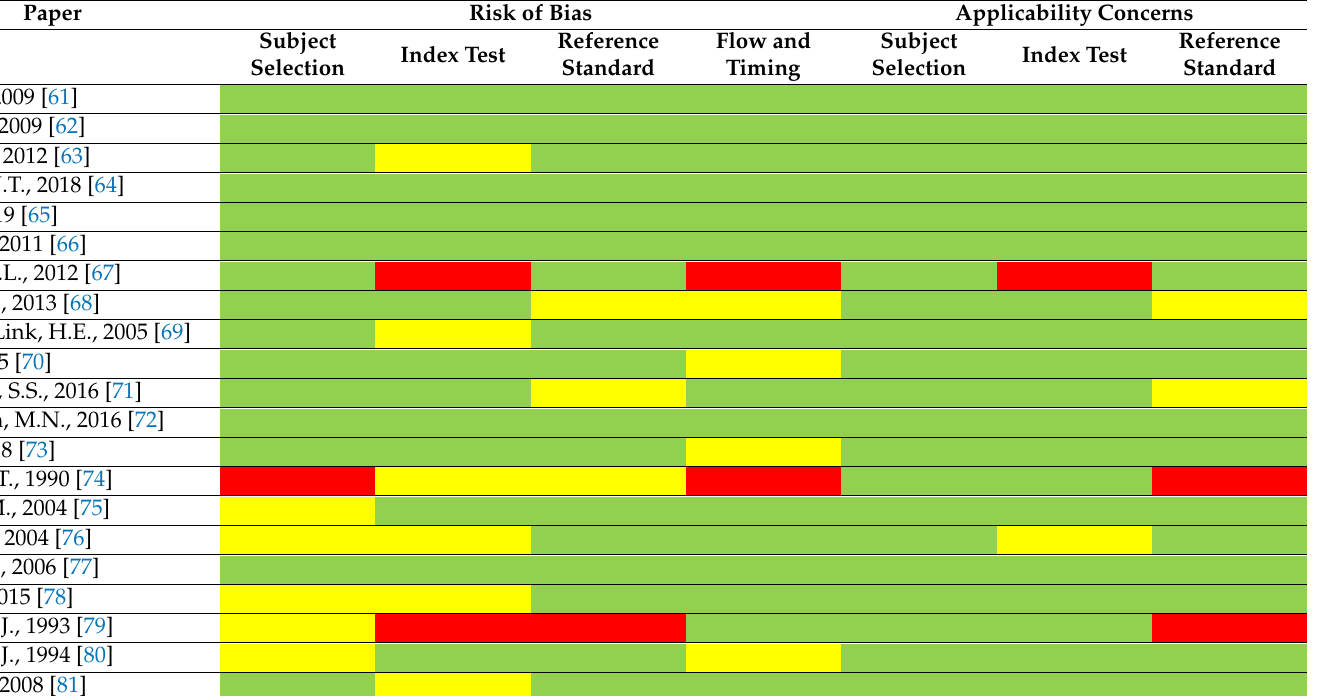
Table 3. Summary of Quality Assessment of Diagnostic Accuracy Studies (QUADAS-2)